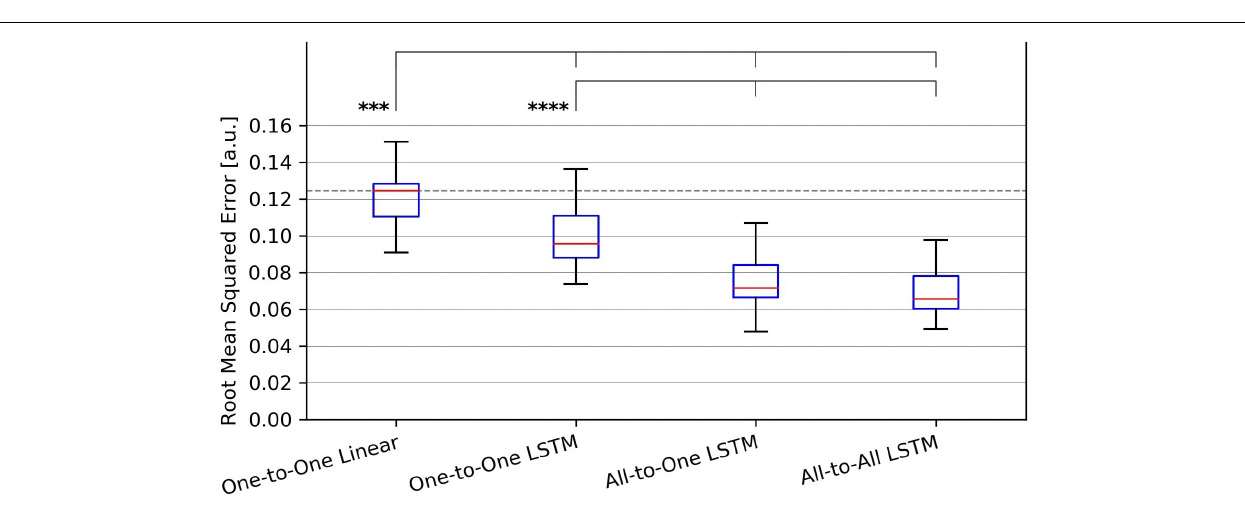
FIGURE 3 | Tukey box plot of Root-Mean-Squared Error (RMSE) metrics achieved by all evaluated force regression methods. Whiskers extend 1.5 interquartile ranges below and above the first and third quartile, respectively. *** p < 0.001 and **** p <